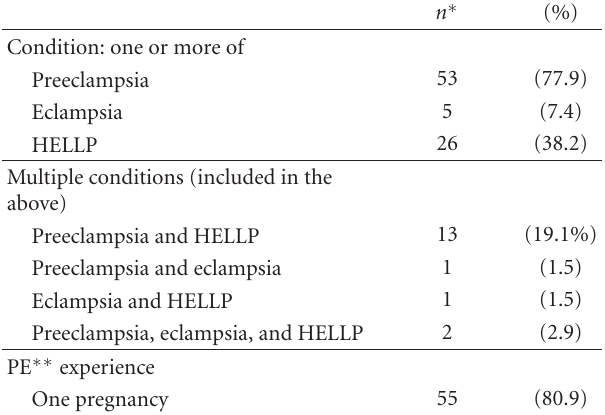
Table 1: Characteristics and outcomes of